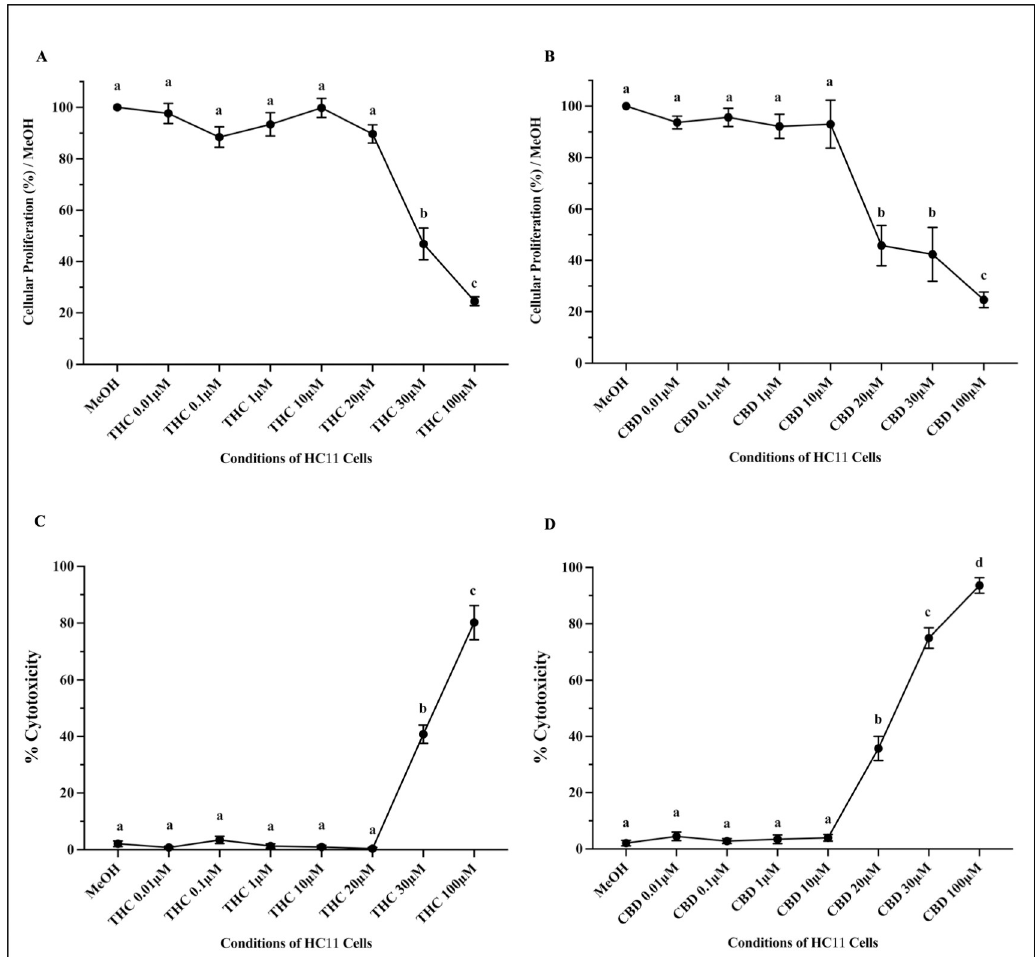
Fig 3. High concentrations of THC and CBD reduced proliferation and viability of HC11 cells. HC11 cells were seeded in base media for 24 hours, supplemented with EGF and INS for 3 days, and differentiated in base media containing PRL, INS and DEX, as described in methods, and treated with vehicle control (MeOH), or 0.01, 0.1, 1, 10, 20, 30, 100 μ M THC (A and C) or CBD (B and D) for 4 days. Changes in cellular proliferation and toxicity were evaluated using a MTS assay and LDH assay, respectively, as described in methods. (A-B) Changes in absorbances were recorded following a MTS assay and results were normalized to vehicle control (MeOH) as a percentage. (C-D) The relative cytotoxicity of THC and CBD was assessed using a LDH assay and percent cytotoxicity (compared to the vehicle control) was plotted. All experiments were repeated with 6 distinct replicates. Results were represented as mean ± SEM and compared using one-way ANOVA. Statistically significant changes were indicated by distinct